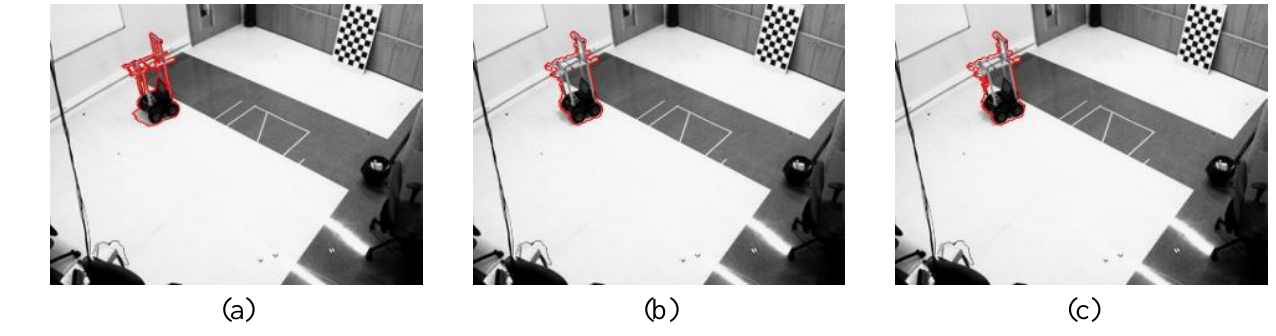
Figure 8. Boundaries of the segmentation obtained after the objective function minimization for one image belonging to the sequence 1 (Figure 7(a)). (a) Curves obtained using one camera (b) Curves obtained using two cameras (c) Curves obtained using three cameras.